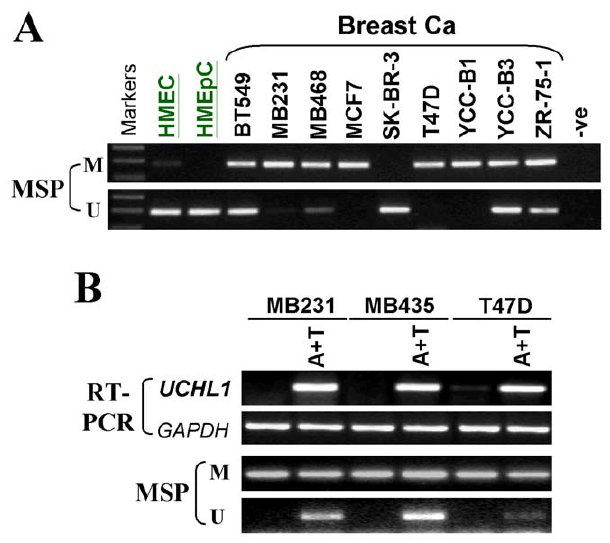
Figure 2. UCHL1 methylation in breast cancer cell lines and reactivation of UCHL1 by demethylation. (A) UCHL1 is frequently methylated in breast cancer cell lines. (B) Pharmacological demethyl- ation restores UCHL1 expression. A + T: Aza and TSA treatment. M, methylated; U, unmethylated.